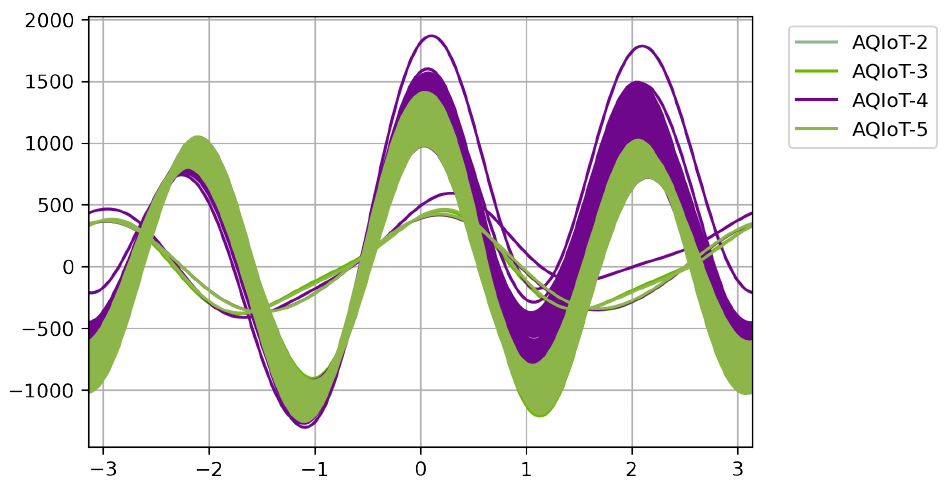
Figure 5. Andrews plot for outdoor air quality monitoring stations data.